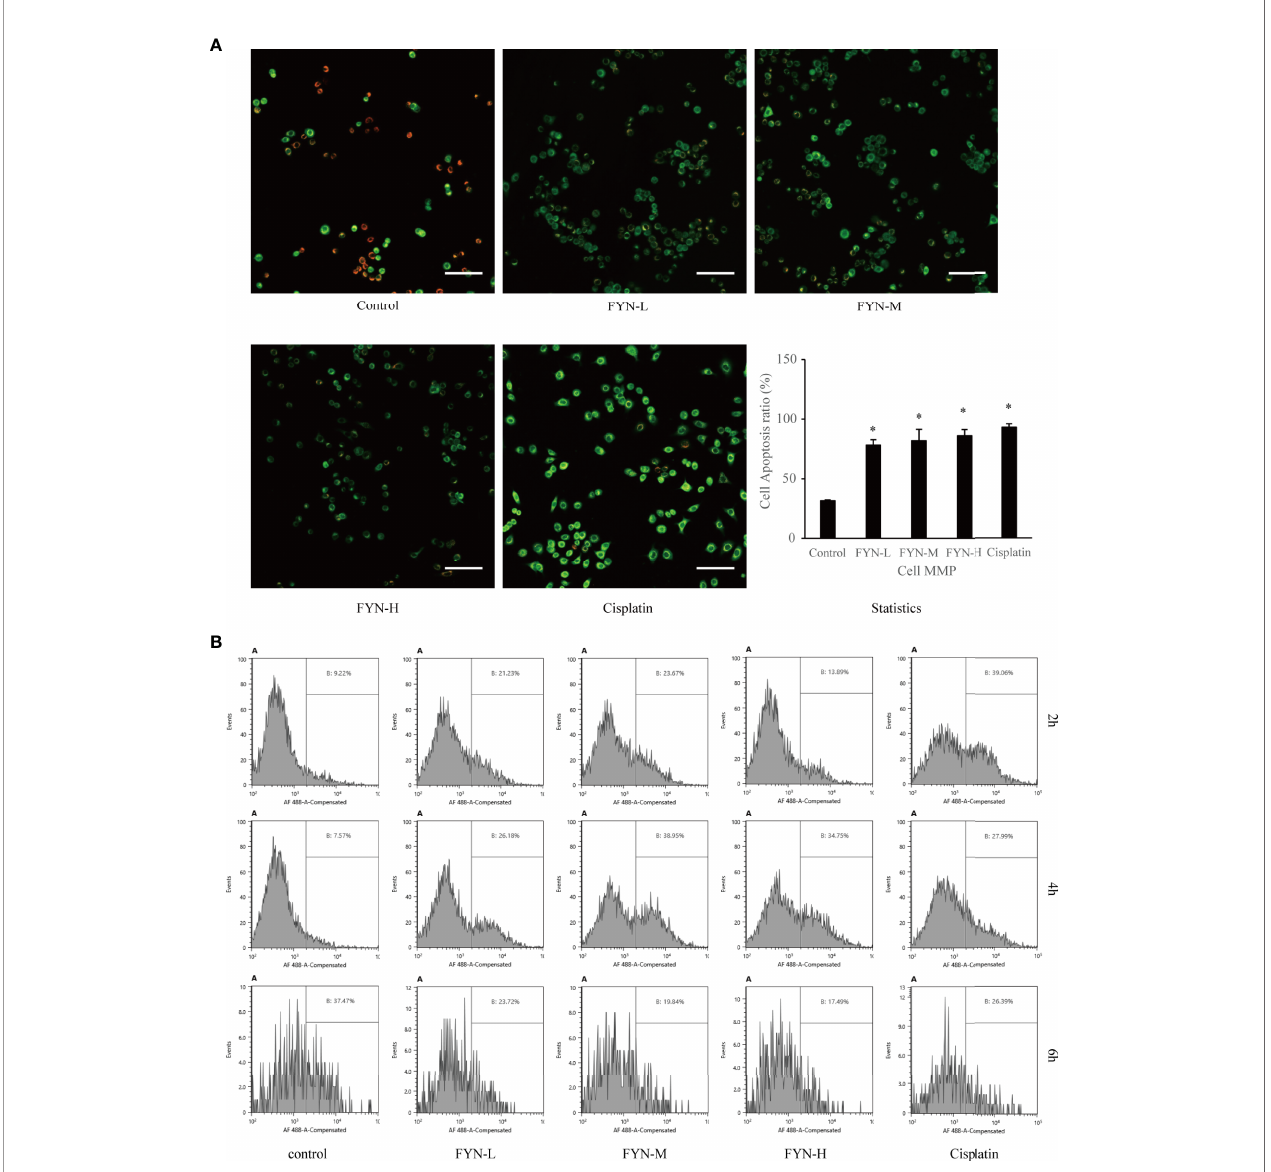
FIGURE 7 | Mitochondrial membrane potential and calreticulin surface expression of A549 cells treated with FYN. (A) FYN induces mitochondrial depolarization in A549 cells. A549 cells were treated with different concentrations of FYN for 6 h, and MMP was assessed using JC-1 staining (scale bar: 100 m m). *Signi fi cant difference from the value of control group (p<0.05). (B) Surface translocation of calreticulin in A549 cells treated with FYN. Flow cytometric pro fi les of calreticulin staining in A549 cells after the indicated treatments with control, FYN, or